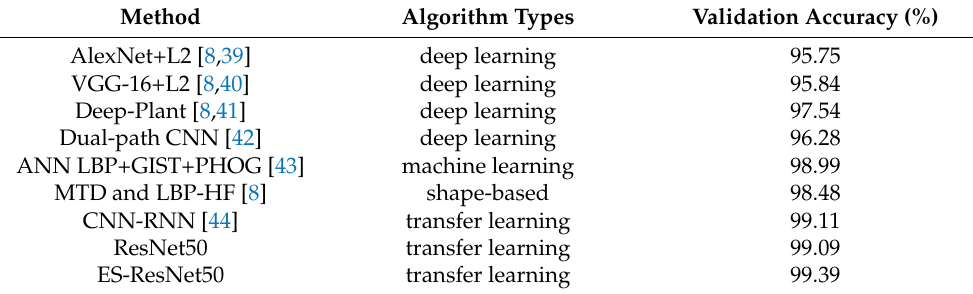
Table 7. Comparison with other methods on the Swedish leaf